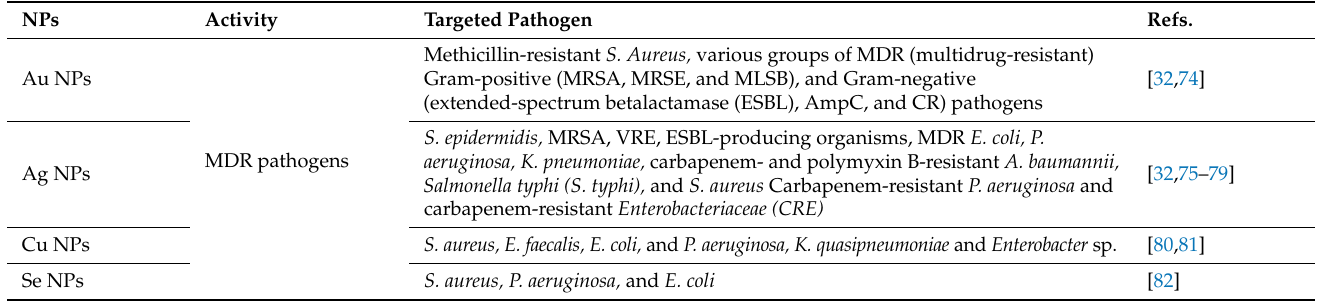
Table 1. Activities of different NPs against MDR-pathogens, antibacterial, antifungal and antiviral. NPs Activity Targeted Pathogen